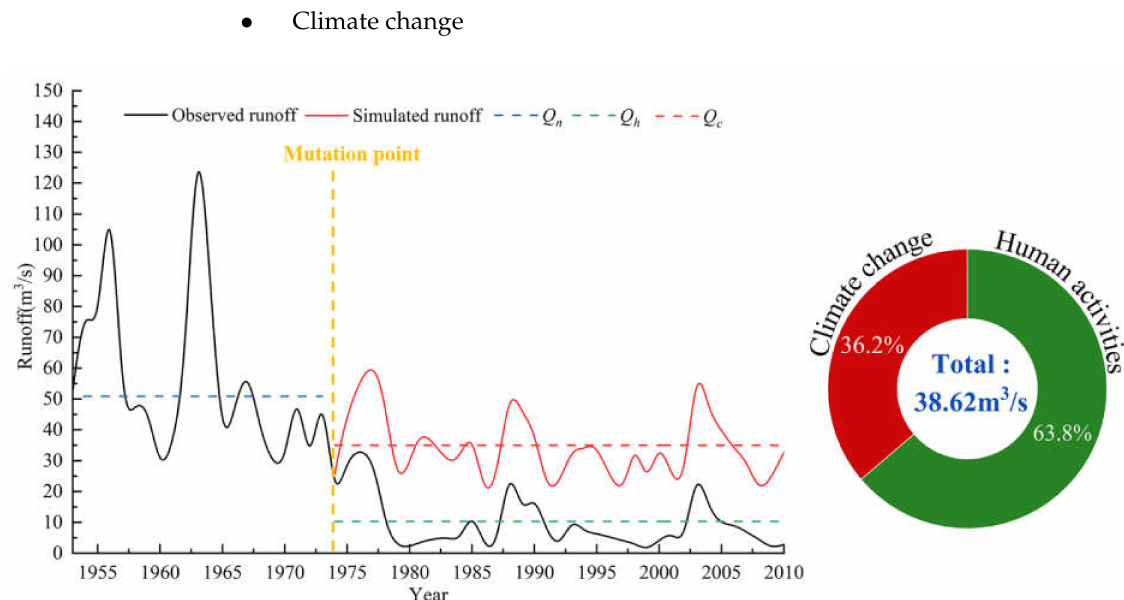
Figure 5. Runoff attribution analysis